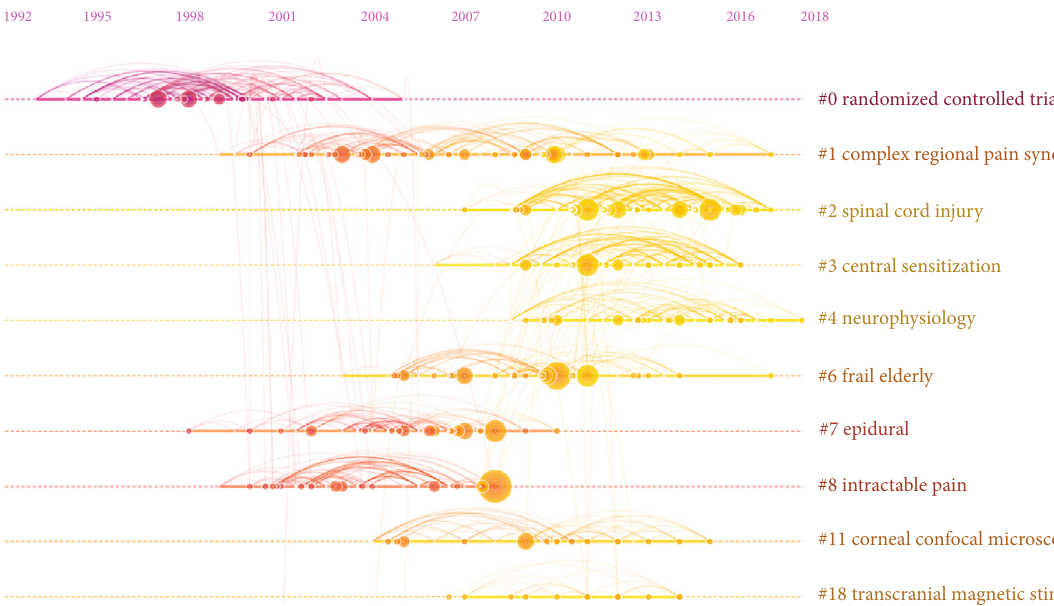
Figure 6: The analysis of references. Cocitation map (timeline view) of references from publications on neuropathic pain rehabilitation research. Table 4: The top 10 journal of origin of papers in the neuropathic pain rehabilitation